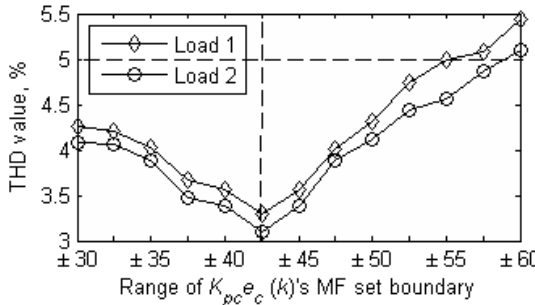
Figure 5. Relationship between variable K pc e c ( k ) ’s Membership Function set boundary and THD